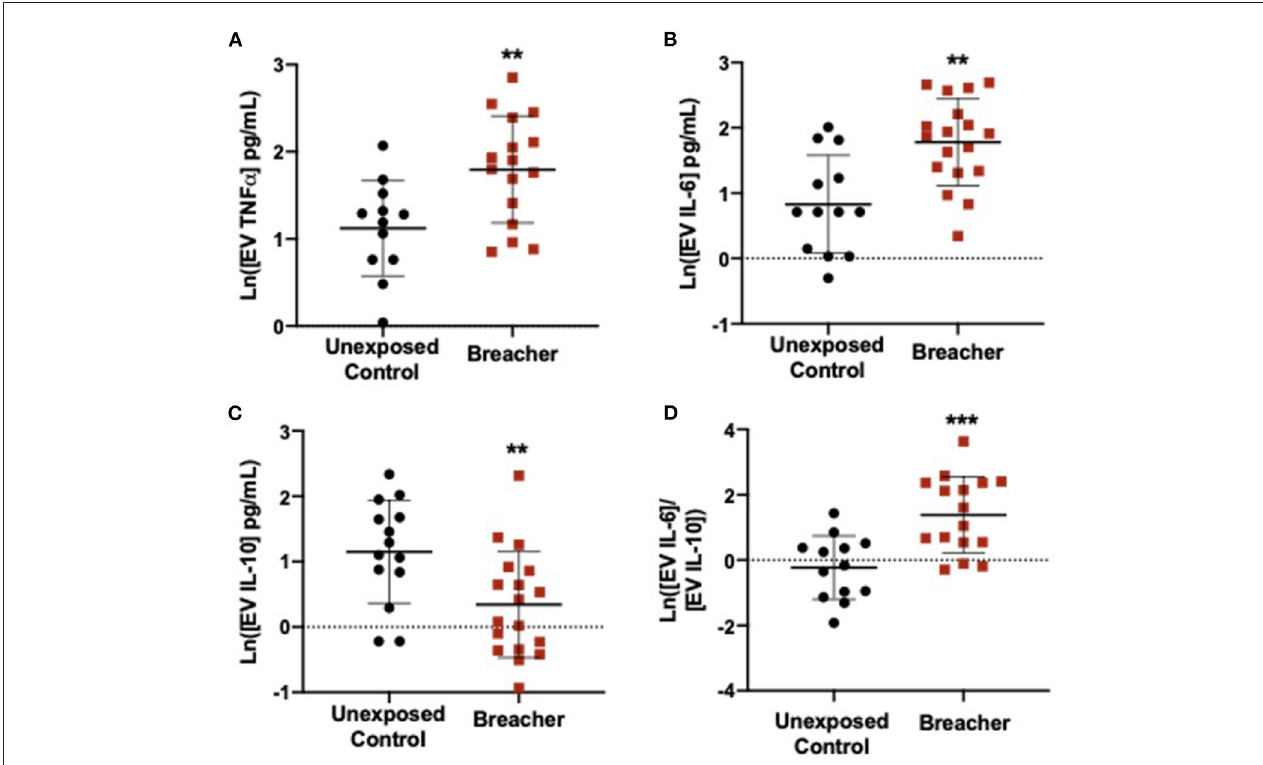
FIGURE 2 | Neuronal-derived EV cytokines propagate a pro-inflammatory environment in the brain. (A,B) EVs derived from neurons contain elevated levels of pro-inflammatory cytokines TNF α and IL-6 in experienced breachers when compared to unexposed controls. In addition, (C) anti-inflammatory cytokine IL-10 is decreased in this population. (D) The ratio of pro/anti-inflammatory cytokines IL-6/IL-10 is higher in experienced breachers. Significant p -values are represented as: ** p < 0.01, *** p < 0.001.